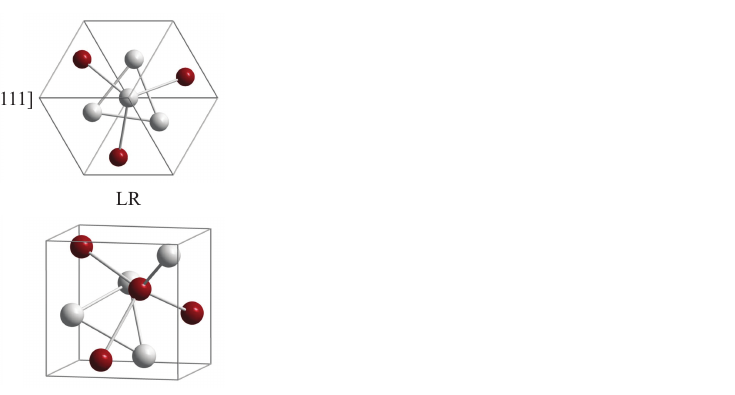
Figure 6. The B 20 structure of FeSi. The enantiomorphous pair RL and LR is shown with ( u Fe , u Si ) = ( 0.3858,0.094 ) and ( 0.6142,0.906 ) , respectively. RL implies that Fe atoms are positioned in an R type and Si in an L type structure and the opposite for LR. Both structures are shown for views along the [111] axes and arbitrary axes. Fe (or Si) atoms in the triangles of the [111] view are in the same √ (111) plane; these planes appear at a distance of ( 2 − u i ) / 3 from the origin. Atoms in the center, on √ the [111] axis, are in a different plane u i 3 away from the origin. See Figure 3 for the positions of the screw axes. Connections between atoms are drawn for better visibility and may not be confused with bonds.